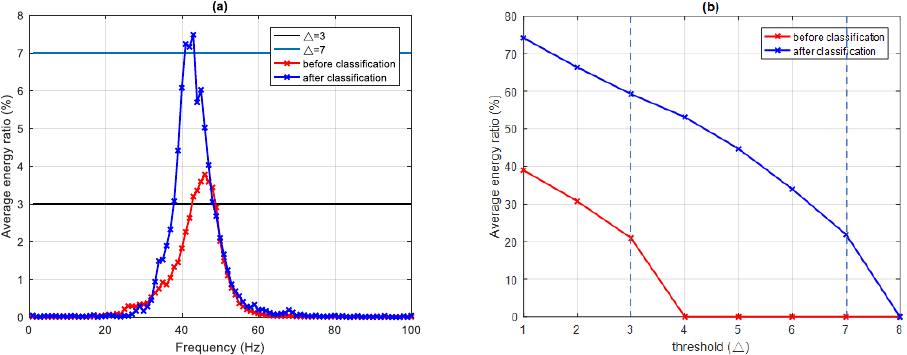
Figure 9. MF1 of class I, ( a ) average frequency – energy distribution comparison of before and after classification with △ = 3%, and △ = 7%, and ( b ) threshold and average energy ratio distribution with before and after classification.